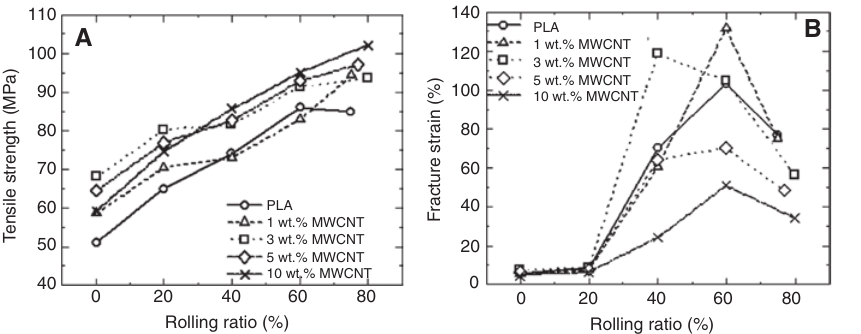
Figure 5: Tensile properties at various rolling ratios: (A) tensile strength and (B) fracture strain (parallel to rolling